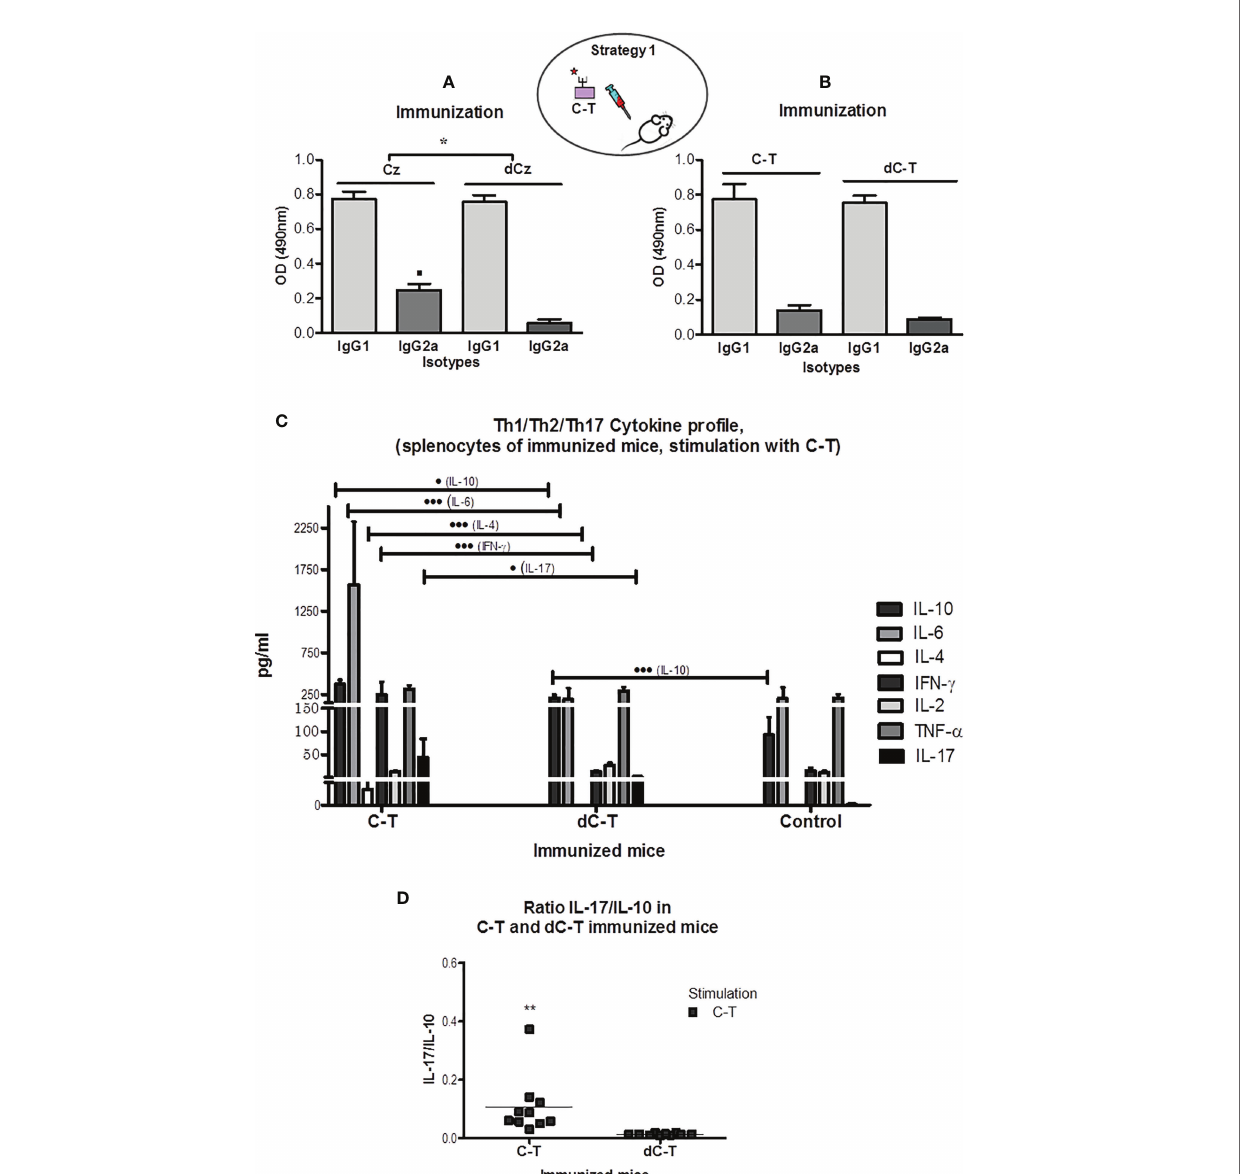
FIGURE 2 | IgG1 and IgG2a humoral immune responses in sera from BALB/c mice exposure of GlcNAc6S by immunization with Cz, C-T, and its desulfated counterparts. Determination of IgG2a/IgG1 ratios. IgG1 and IgG2a isotype levels were measured in sera from Cz IM and dCz IM (A) and C-T IM and dC-T IM (B) by ELISA. In each case, the antigen adsorbed in the plate is Cz. The bars represent the averages of duplicate determinations, and the error bars indicate the SD. (A) ▪ p < 0.05 vs. IgG2a dCz. IgG2a/IgG1 ratios * p < 0.001 Cz IM vs. dCz IM . (C) Flow cytometry measurement of the cytokine levels of IL-10, IL-6, IL-4, IFN- g , IL-2, TNF- a , and IL-17 in supernatants of spleen cell cultures from C-T IM , dC-T IM , and control mice, stimulated with C-T. The supernatants were obtained after 48 h of stimulation with C-T (10 m g/ml). The concentration of each cytokine (pg/ml) was obtained with the software BD FCAP Array v3.0. The bars represent the average of six determinations by duplicate with their SD. Production of IL-10: (cid:129) vs. dC-T IM ; (cid:129)(cid:129)(cid:129) vs. control mice. Production of IL-6: (cid:129)(cid:129)(cid:129) vs. dC-T IM ; production of IL-4: (cid:129)(cid:129)(cid:129) vs. dC-T IM . Production of IFN- g : (cid:129)(cid:129)(cid:129) vs. dC-T IM . Production of IL-17: (cid:129) vs. dC-T IM . ( (cid:129) p < 0.05; (cid:129)(cid:129)(cid:129) P < 0.001). (D) Determination of IL-17/IL-10 ratio in C-T IM and dC-T IM , calculated from levels obtained by fl ow cytometry. The values of the IL-17 and IL-10 concentrations used were those obtained with C-T as stimulant. (** p = 0.0083; C-T IM vs. dC-T IM ). The oval scheme in the upper part of the fi gure represents strategy 1. IgG2a/IgG1 ratios *p < 0.001 CzIM vs. dCzIM. The symbol means p minor to